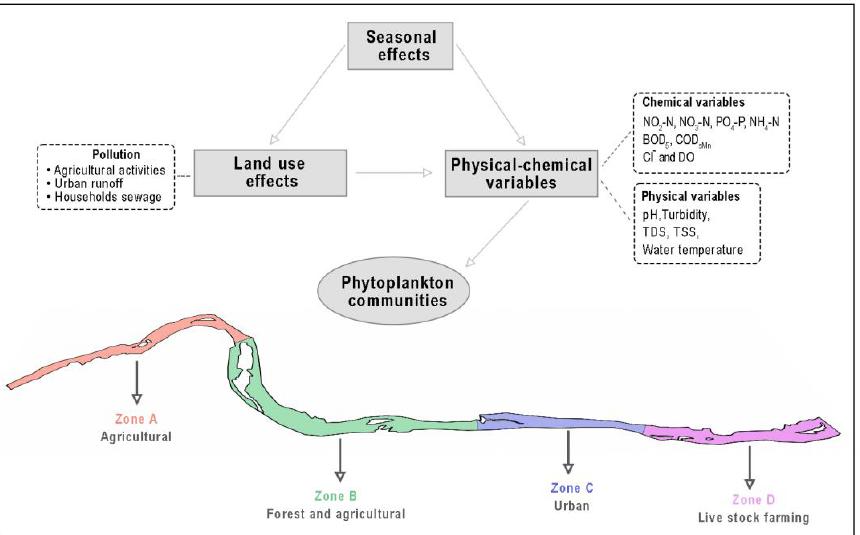
Figure 1. Conceptual framework represents the expected relationship between variables and